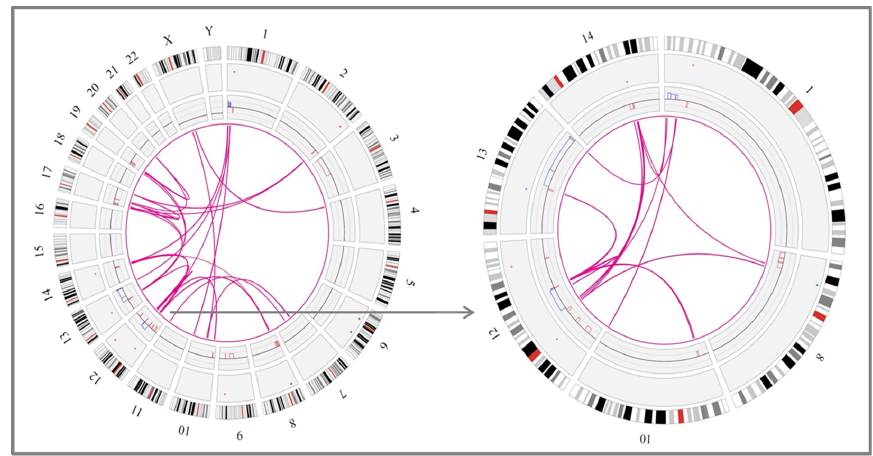
Figure 3. Example of a case with chromothripsis that shows multiple rearrangements with other chromosomes when analyzed by optical genome mapping. Overall, the karyotype of this patient presented a high complexity, with several bits of additional material found in different chromosomes and a few chromosome markers (case #16). Chromosome 12 displayed monosomy by CBA (highlighted in red in the karyotype) but when analyzed by GM and OGM, this chromosome showed an identical pattern of chromothripsis, with >10 switches between 2–3 copy number states. In addition, OGM identified several rearrangements among different chromosomes, as shown in the Circos plot depicted at the bottom of the figure. This highly complex profile could be associated with another catastrophic phenomenon known as chromoplexy, characterized by the presence of multiple chained translocations. Those additional chromosomes associated with chromothriptic events are highlighted in bold in the karyotype.